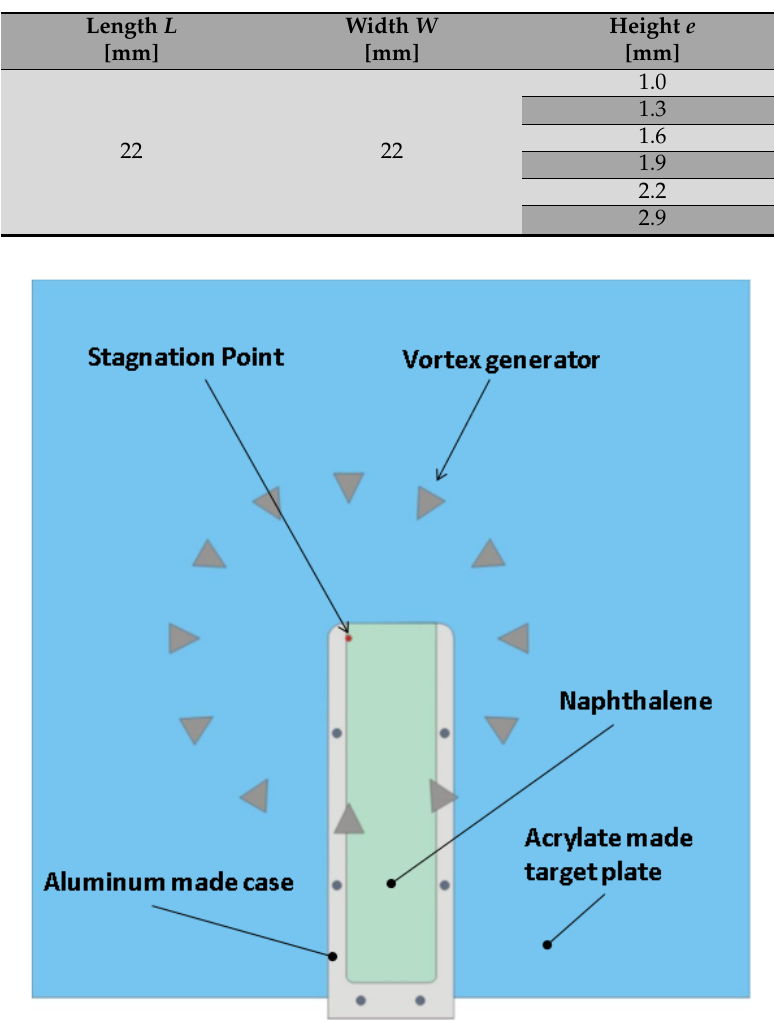
Figure 4. Layout of VGs on the target plate. Table 1. Dimensions of circular ribs.